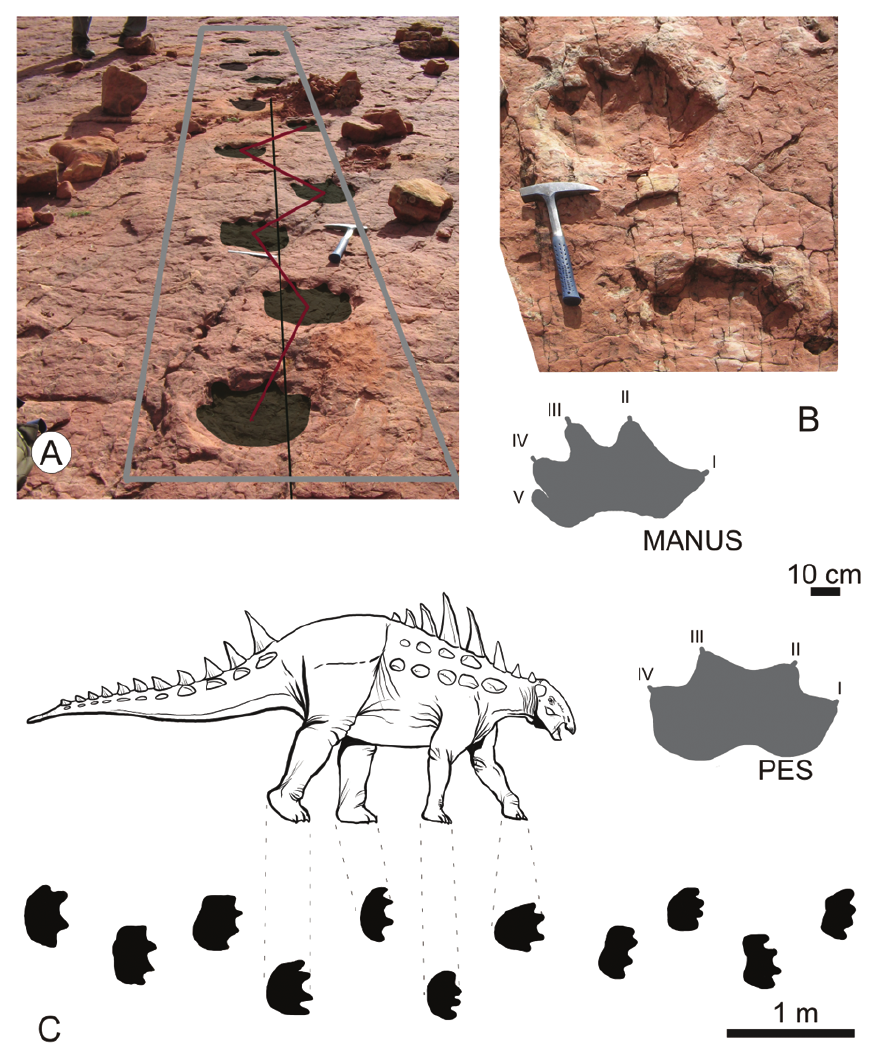
Fig. 4 – Ichnotaxon C. Trackway (A), isolated pes and manus of adult specimens in photograph (B up) and scheme (B down), detailed trackway scheme with distances preserved